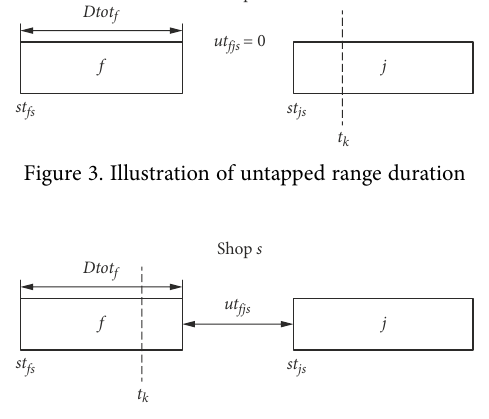
Figure 4. Illustration of untapped range duration